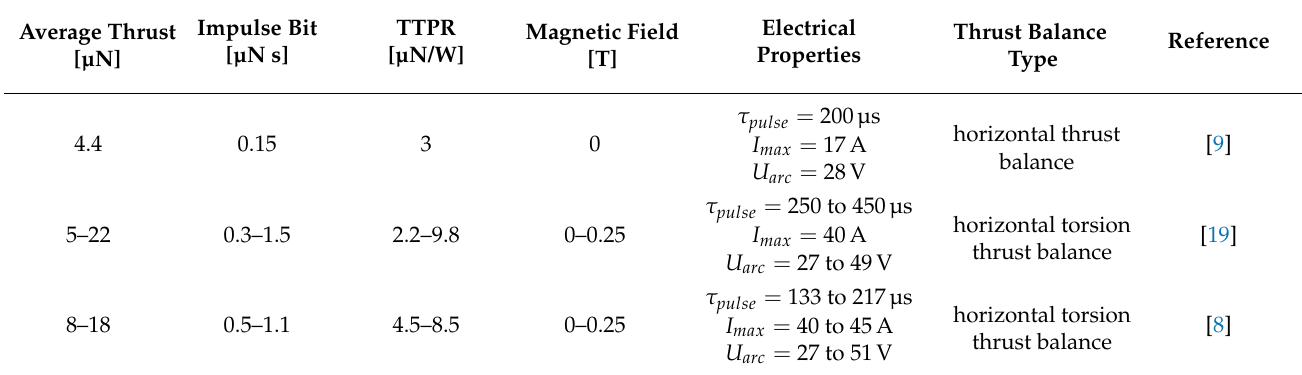
Table 2. VAT thruster operating conditions and performance for systems comparable to this